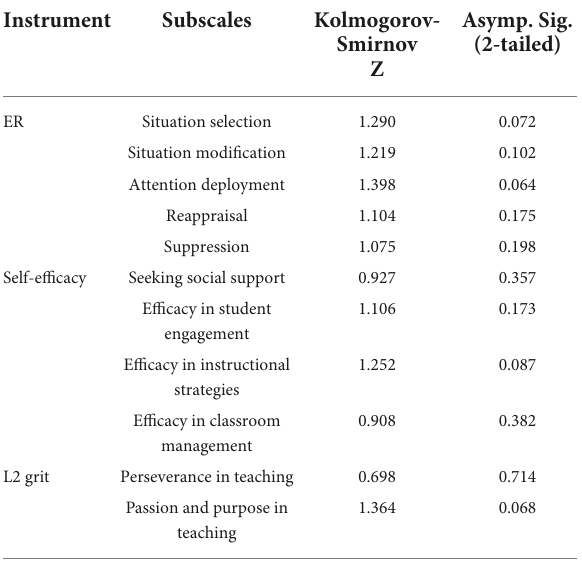
TABLE 2 The results of Kolmogorov-Smirnov test.